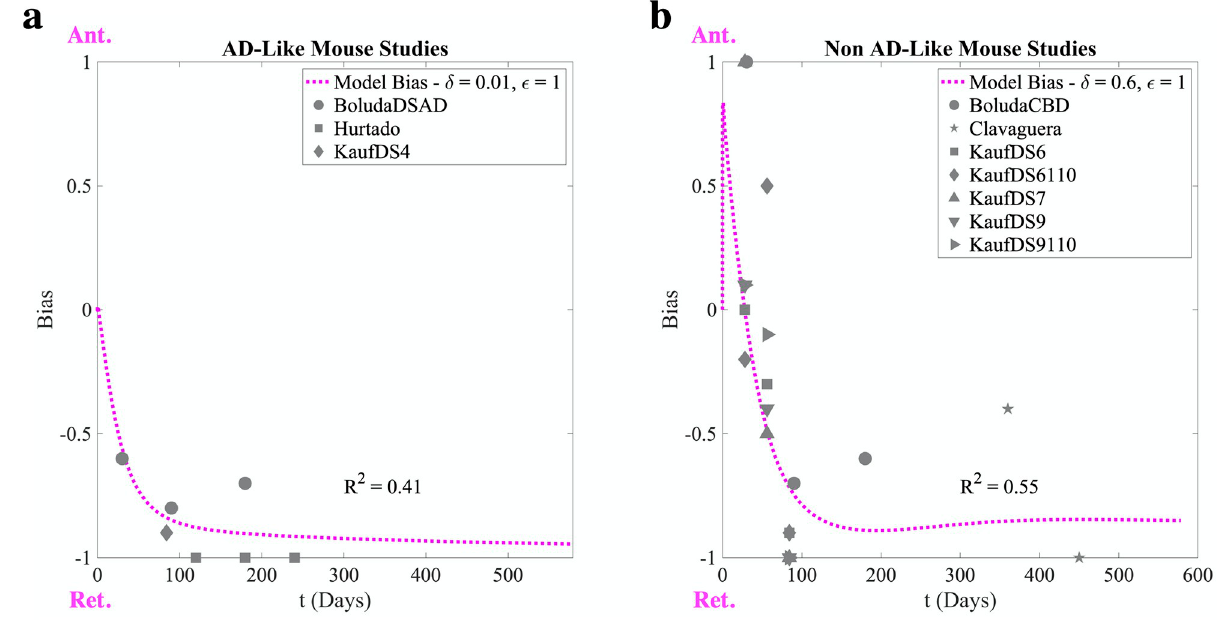
Fig 6. Tau transport feedback recaptures the directionality of mouse tauopathy models. (a) The AD-like mouse models explored by [20] exhibit a strong retrograde bias that becomes more pronounced over time, which can be replicated in the two-neuron system with weak anterograde-directed transport feedback (low δ relative to � ). (b) The non-AD-like mouse models similarly have a trend towards increasing retrograde bias, although to a lesser extent than the AD-like studies and there is evidence of early anterograde bias, which is captured by fixing both δ and � at high values. For all studies, we first linearly transform the bias parameter, s , used by [20] onto the [ − 1, 1] scale of our SD bias estimates before plotting. Refer to S2 Table for a full parameterization of both simulations and Methods: Analysis . Studies included: [11, 13, 36, 37].